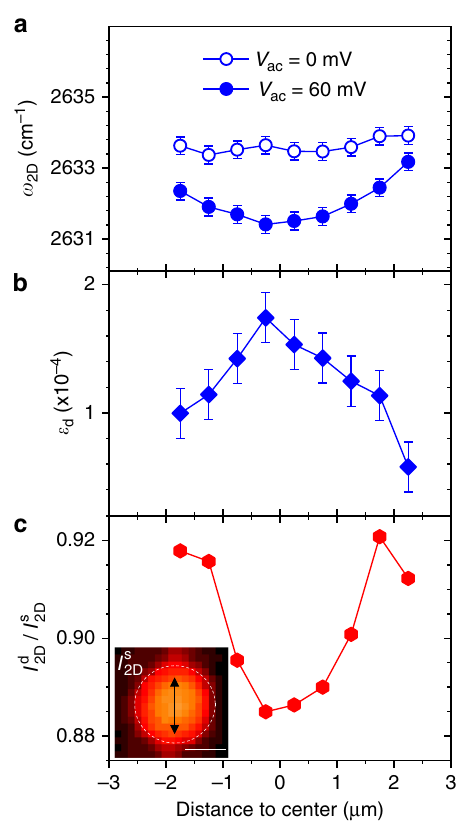
Fig. 4 Mapping dynamically-induced strain. a Frequency of the Raman 2D mode along the cross-sections highlighted in c in a graphene drum (device 2, 3 μ m radius) at V dc = − 6 V and V ac = 0 mV (open symbols) and V ac = 60 mV (full symbols). b Dynamical strain ε d obtained from the difference of the data in a . c Ratio of the Raman 2D-mode intensity in the driven ( I d and static ( I s ) cases. Inset: Map of the Raman 2D-mode intensity I s 2D recorded on the graphene drum (see white dashed contour), at V dc = − 6 V and V ac = 0 V. The double arrow indicates the location of the line scan. The scale bar is 3 μ